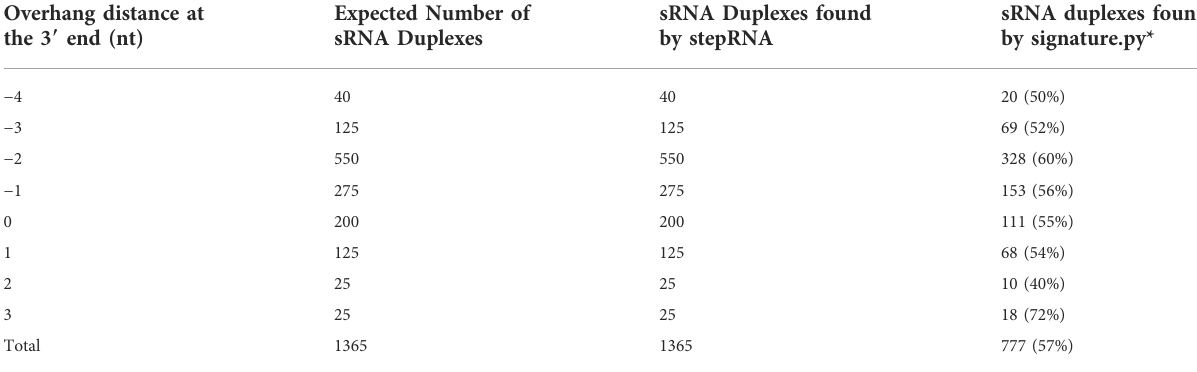
TABLE 2 stepRNA detects more sRNA duplexes correctly compared to signature.py at the 3 ’ end of sRNA duplexes. Overhang distance at the 3 9 end